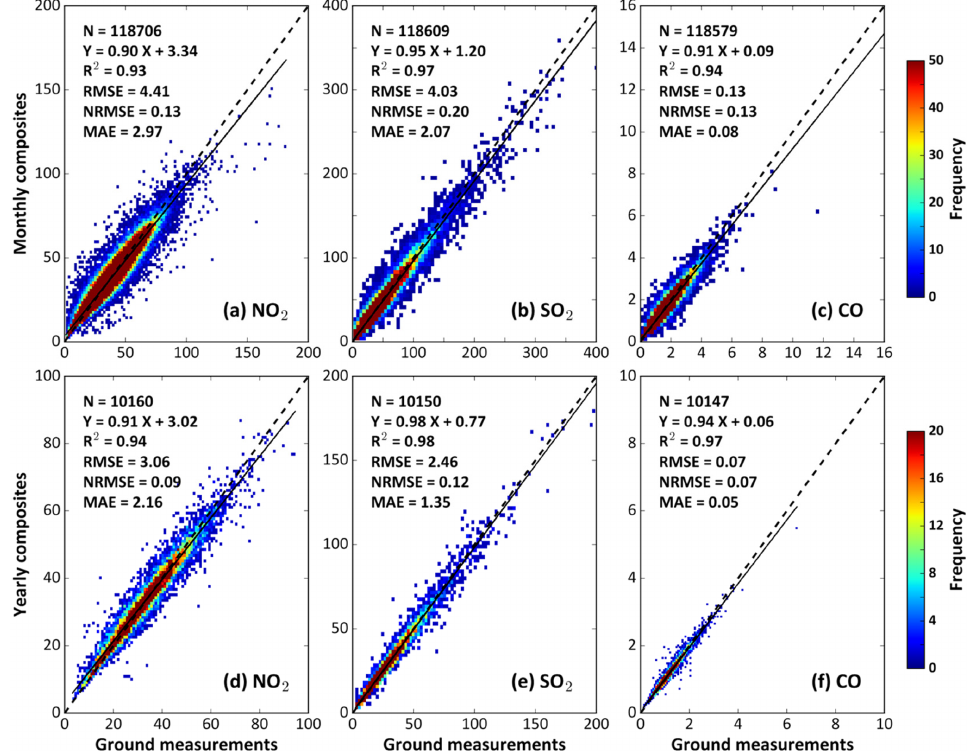
Figure 12. Sample-based temporal validation of (a–c) monthly and (d–f) yearly composites of ground-level NO 2 (µgm − 3 ), SO 2 (µgm − 3 ), and CO (mgm − 3 ) as a function of ground measurements from 2013 to 2020 in